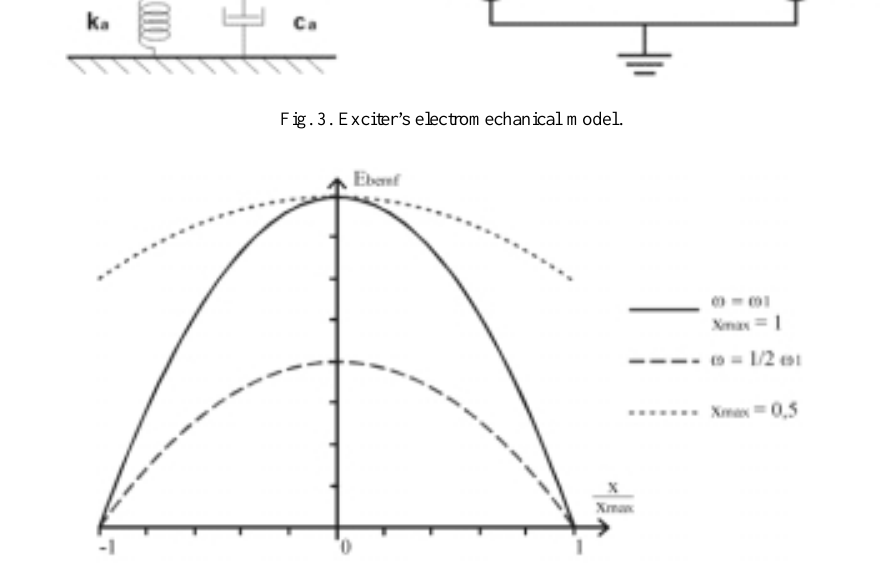
Fig. 4. E bemf behaviour due to frequency and amplitude